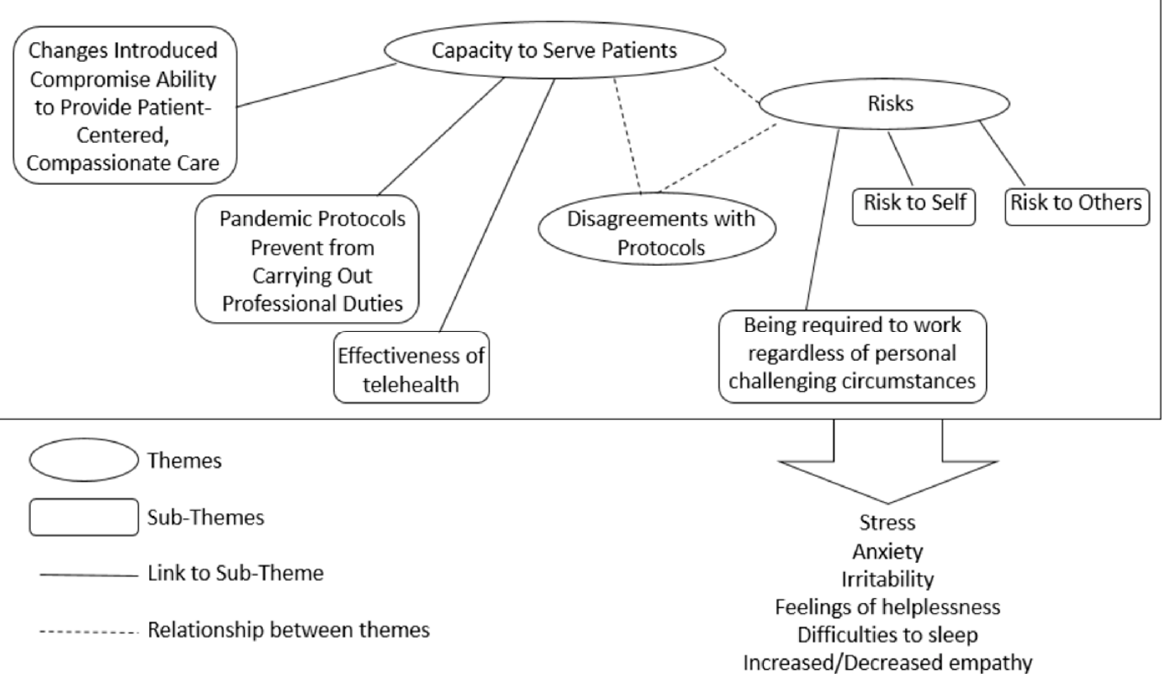
Figure 2. Graphical depiction of the thematic framework showing 3 main themes and 6 sub-themes underlying moral distress experiences of BC HCWs during COVID-19.